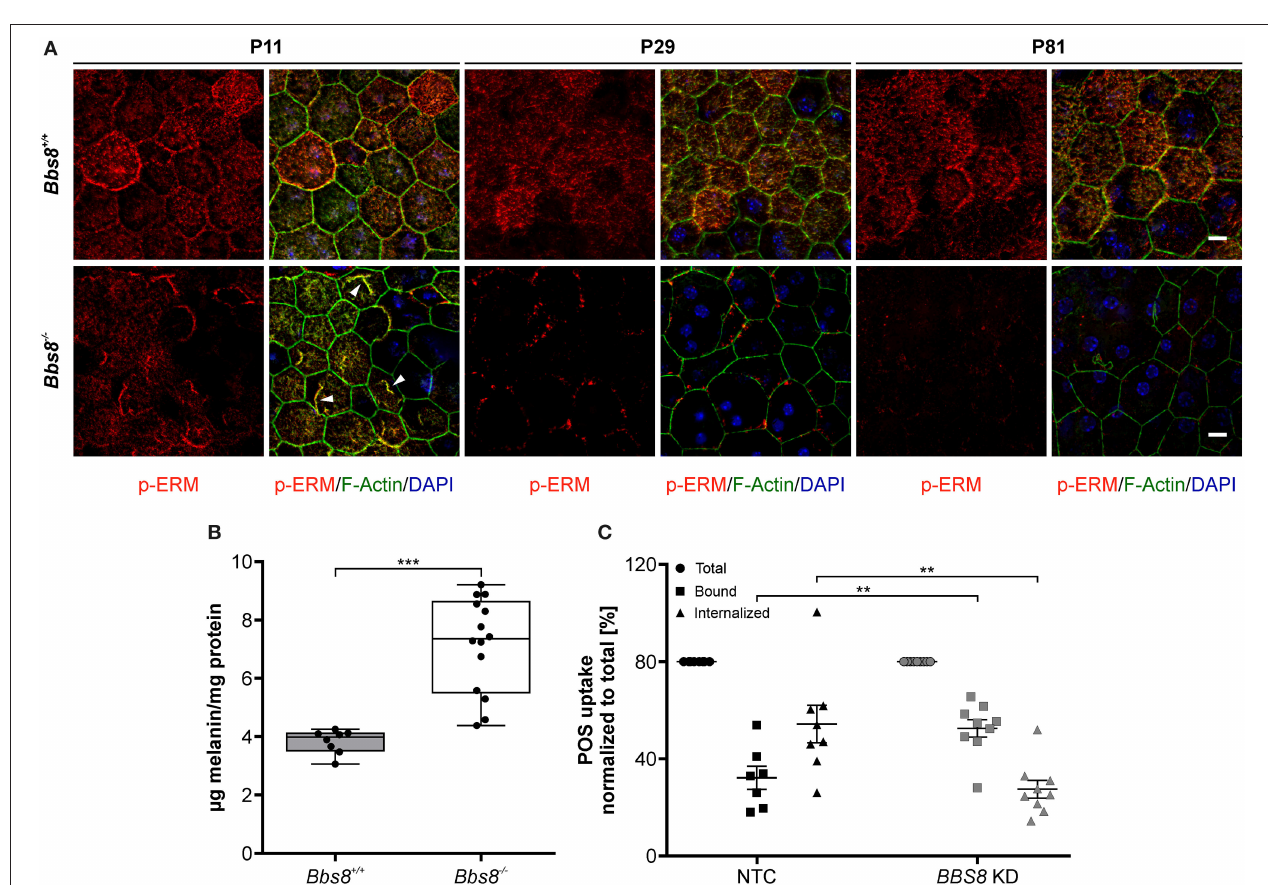
FIGURE 7 | Deletion of Bbs8 leads to defects in RPE function . (A) Representative images of RPE flatmounts stained for p-ERM (red) and F-actin (green) to visualize apical microvilli and the cytoskeleton. DAPI was used to stain nuclear DNA. P11 Bbs8 − / − RPE shows abnormal accumulations of p-ERM staining (arrowheads). Staining of p-ERM is dramatically reduced as the tissue ages. Bbs8 + / + RPE shows consistent staining at all ages. Scale bars: 10 µ m. (B) Retinal adhesion assay. Quantification of melanin attached to the retina is significantly increased in P16 Bbs8 − / − compared to controls ( p < 0.0001). Statistical analysis was performed using ROUT test (Q = 0.1 %) identified 2 outliers before using unpaired t -test ( n : Bbs8 − / − = 14, Bbs8 + / + = 8). (C) Phagocytosis assay. Quantification of photoreceptor outer segments (POS) uptake reveals a significant increase in bound POS ( p = 0.0025) and a significant down-regulation in internalized POS ( p = 0.0025) in BBS8 KD ARPE-19 cells compared to controls. Statistical analysis was performed using ROUT test (Q = 10%) identified 1 outliers before doing a one-way ANOVA and Tukey post-hoc test ( n : BBS8 KD = 9, NTC = 7–8). Significance levels: ≤ 0.01**, ≤